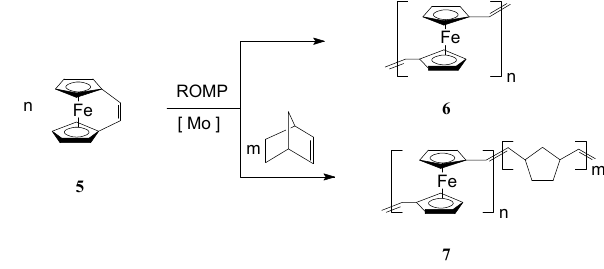
Scheme 2. Synthesis of iron-containing polymers and copolymers by ROMP.